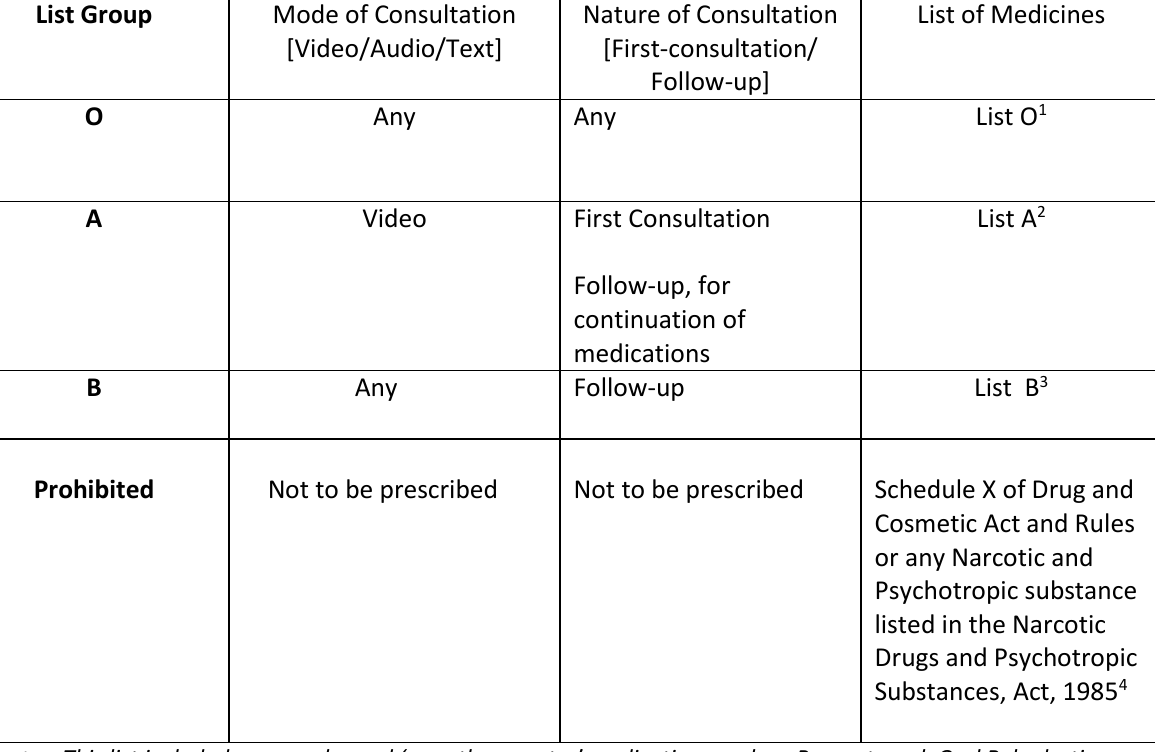
Table: Matrix of the permissible drug lists based on the type and mode of consultation List